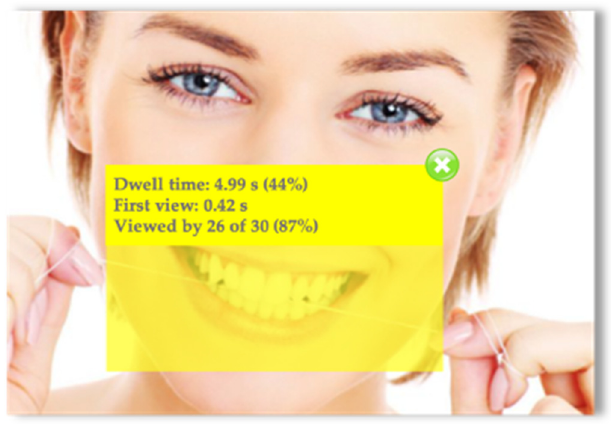
Figure 11. Heatmap analysis: Image B—area 1.